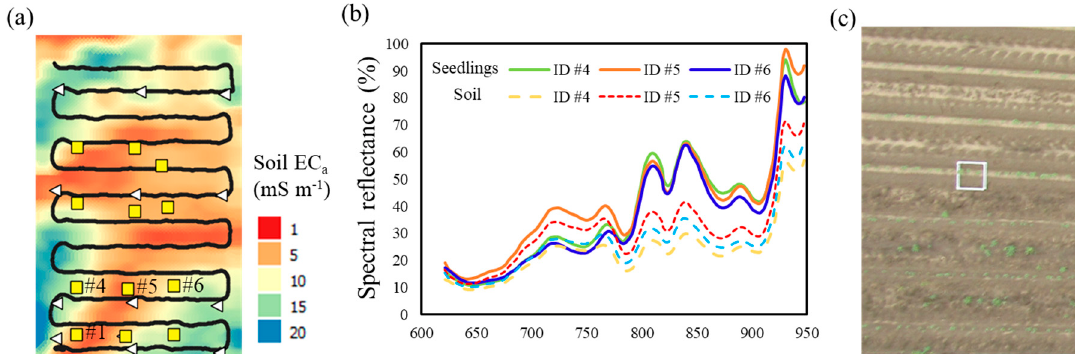
Figure 15. ( a ) Soil EC a map marked with flight paths and ground reference points. The triangles and rectangles have the same meaning as in Figure 2. ( b ) Spectral reflectance of the cotton seedlings and soil at the selected locations #4, #5 and #6 in the research field as shown in (a). ( c ) An RGB image taken at 15 m AGL in location #1 of (a) showing soil color differences due to different soil texture and water content.